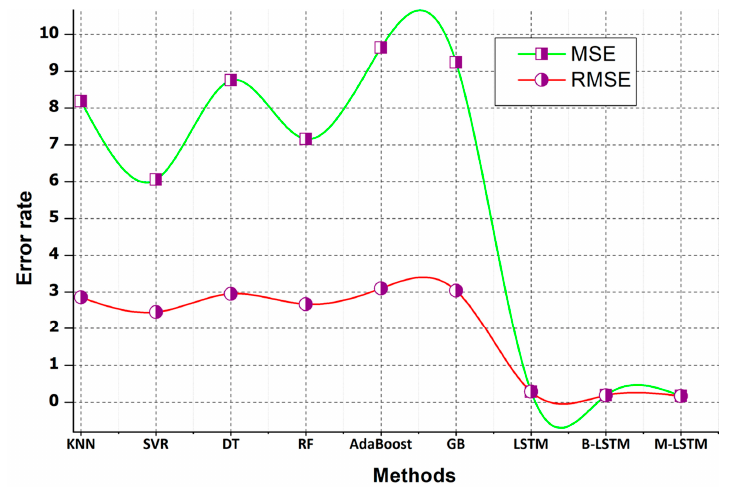
Figure 10. Visual representation of each method using MSE and RMSE for the minutes’ horizon, which shows the better performance of the deep sequential learning algorithms over